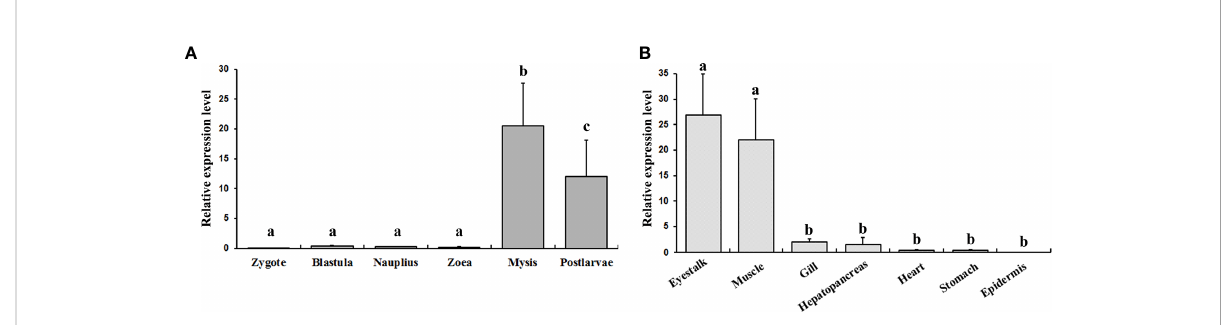
FIGURE 5 EcILP expression pro fi les at different larval stages (A) and different tissues of the adults (B) . X-axis shows the different larval stages or adult tissues. Y-axis shows the relative mRNA expression level. Error bars in each column indicate standard deviation, and different letters on the bars indicated the difference signi fi cance ( P value < 0.05). Early developmental samples were collected as pools, and the tissue expression analysis was collected from twelve adult E. carinicauda .